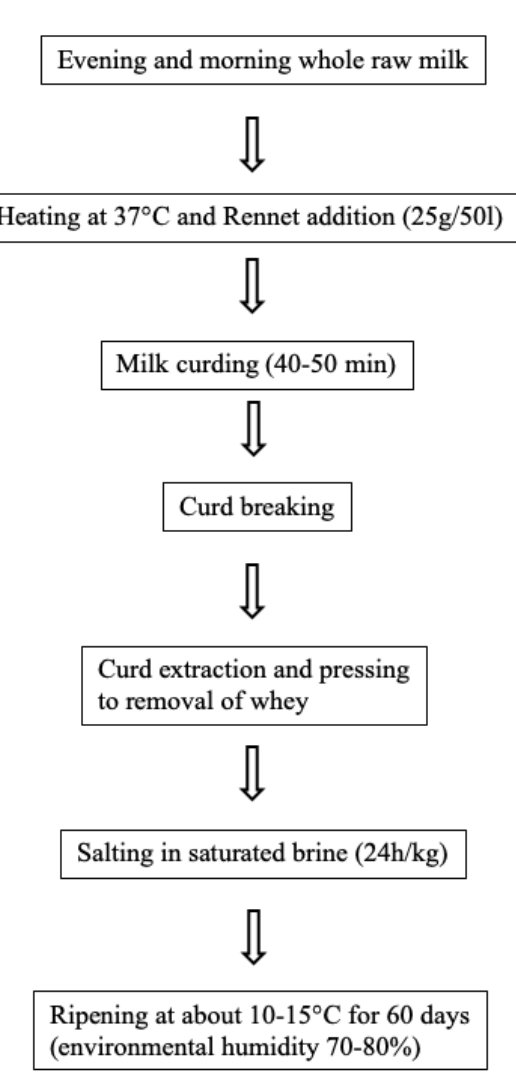
Figure 1. Flowchart of cheese production.